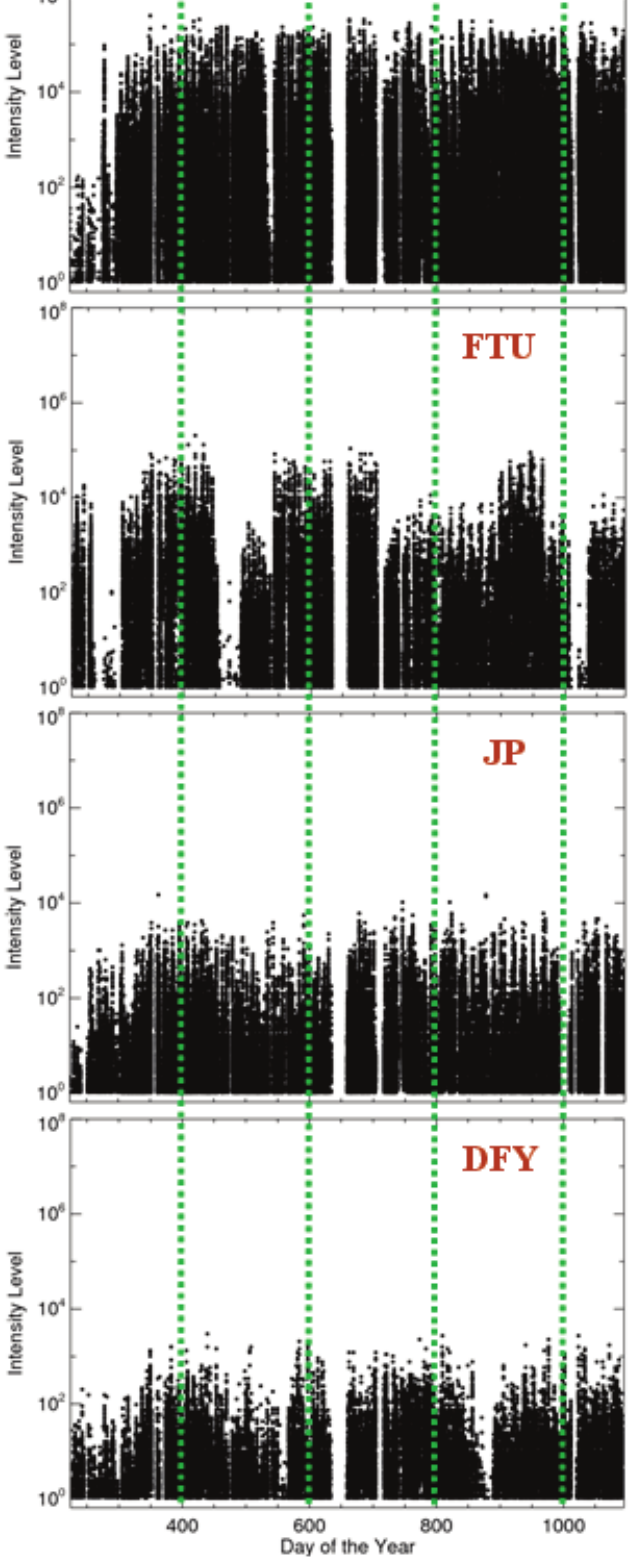
Figure 2. Flux density variations versus the DOY for the VLF transmitter stations in Australia (NWC, top panel), France (FTU, second panel), Japan (JP, third panel), and Germany (DFY, bottom panel).